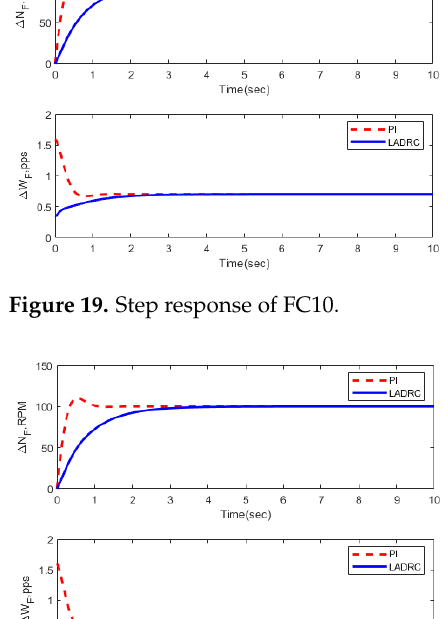
13 of 18 Figure 16. Step response of FC07. Figure 17. Step response of FC08.